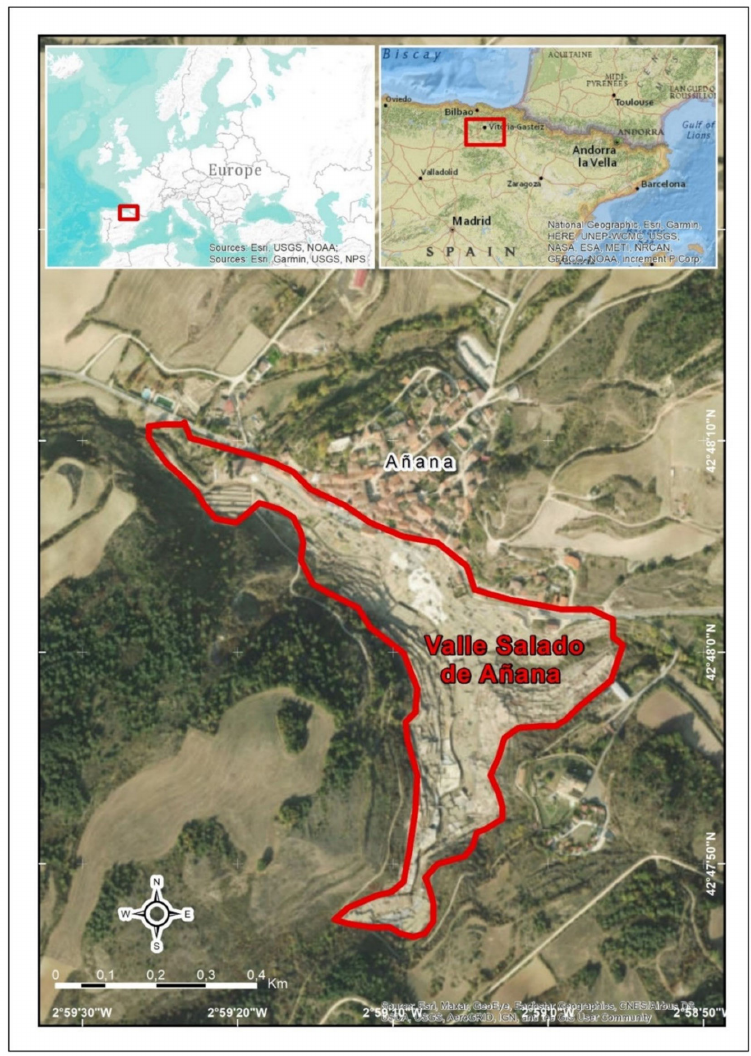
Figure 1. Maps of the study area and location of the Valle Salado de Añana (Spain). The perimeter of the salina is delimited in red. Source: Own